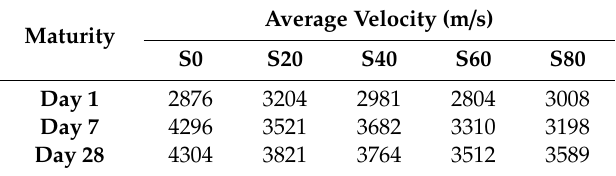
Table 4. P-wave velocity in each concrete cube specimen on di ff erent maturity dates